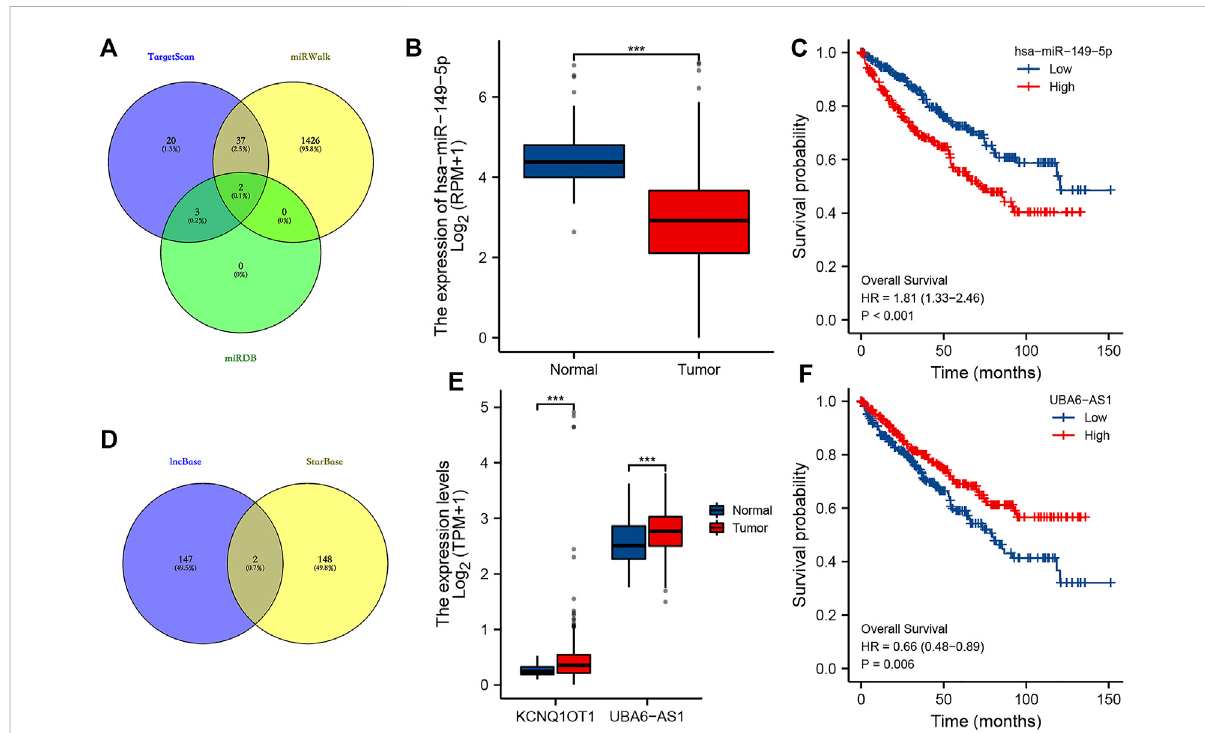
FIGURE 10 LncRNA – miRNA – mRNA regulatory axis in ccRCC. (A) miRNA targets of MMP9 based on the data from TargetScan, miRWalk, and miRDB databases. (B – C) Expression and prognostic analysis of the miRNA target in ccRCC. (D) LncRNA targets of miR-149-5p based on the data from lncBase and starBase. (E – F) Expression and prognostic analysis of the lncRNA target in ccRCC. *** p < 0.001; ccRCC, clear cell renal cell